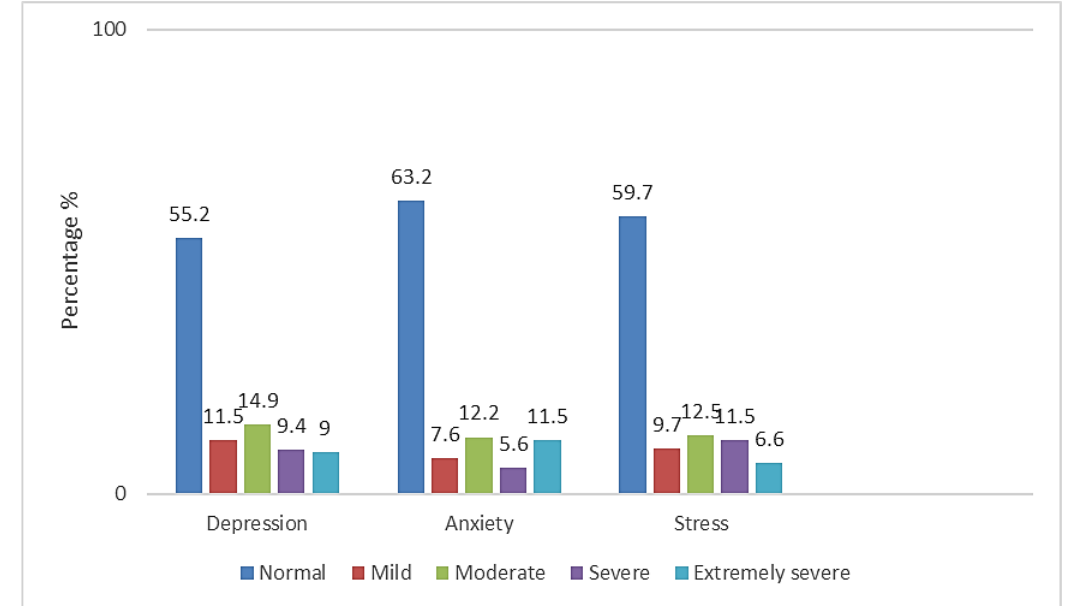
Figure 1. Measured levels of depression, anxiety and stress. Table 3. Description of DASS-21 subscales.